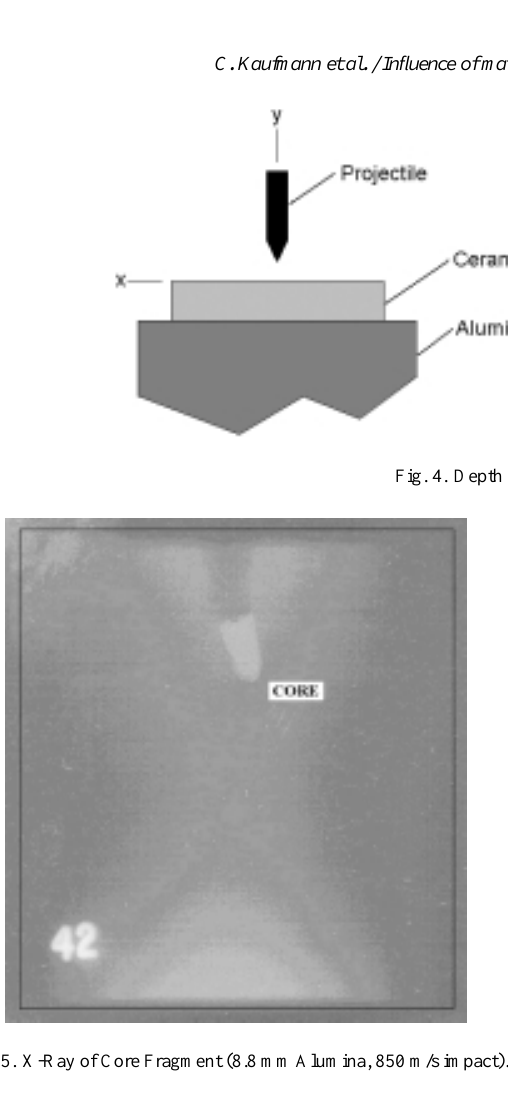
Fig. 5. X-Ray of Core Fragment (8.8 mm Alumina, 850 m/s